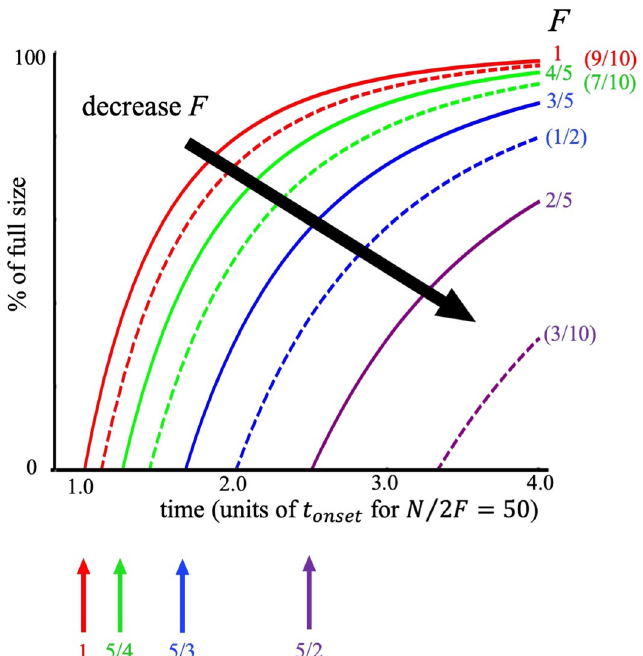
Figure 4. Predicted curves from our theory showing the onset and growth of a gel (i.e. each online group in Figs. 1 and 2, or each overall movement in Fig. 5) and how it depends on the average aggregation probability F . The specific F value is determined by the initial composition of the population and the grouping mechanism, i.e. the collective chemistry, hence we show a variety of possible values as examples. An intervention to this collective chemistry will change F and hence can delay the onset of the gel as shown and curtail its growth. Specifically, the curve can be flattened by reducing the value of F , i.e. by nudging the collective chemistry.